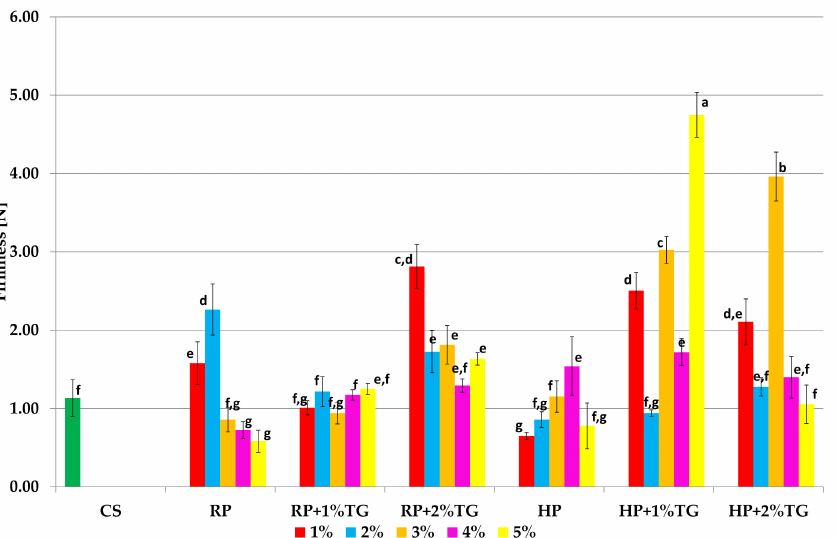
Figure 8. Average firmness values of hydrated instant noodles with the addition of rice protein, hemp protein and TGase (CS—control sample, RP—rice protein, RP+1%TG—rice protein with 1% TGase, RP+2%TG—rice protein with 2% TGase, HP—hemp protein, HP+1%TG—hemp protein with 1% TGase, HP+2%TG—hemp protein with 2% TGase). Columns correspond to various additions of rice protein. Mean values denoted by different letters ( a – g ) represent statistically significant differences between variables ( p <